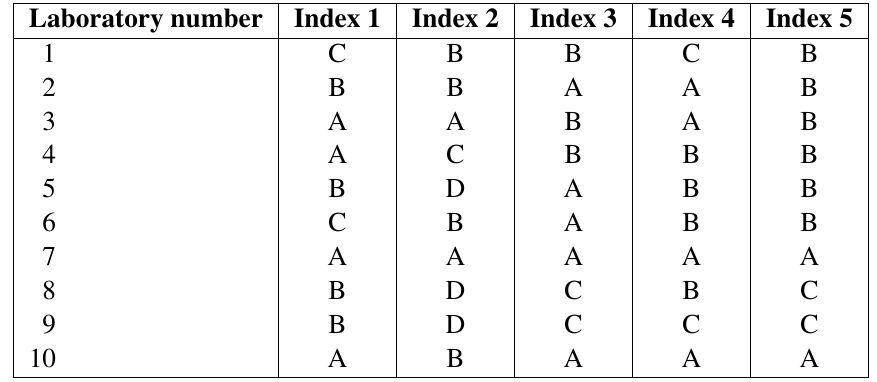
Table 3 Grade system of evaluation